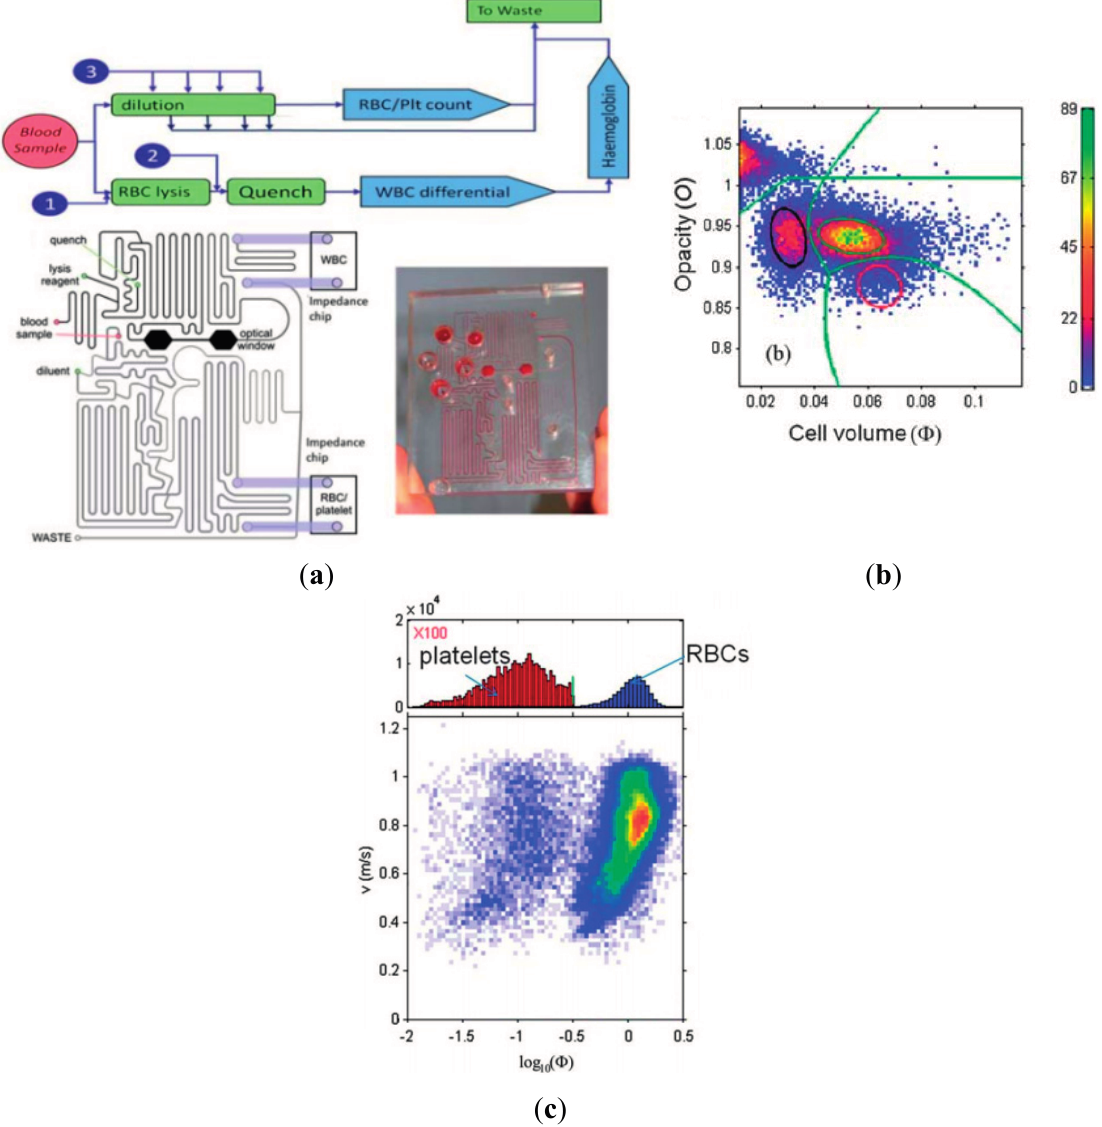
Figure 8. ( a ) The integrated point of care system based on microfluidic impedance flow cytometry enabling whole blood cell counting. The integrated system consists of two parts, an impedance measuring chip and a microfluidic sample preparation block. The bottom arm performs analysis of white blood cells with erythrocytes lysed while the upper arm performs counting of red blood cells and platelets; ( b ) The impedance scatter plot of cell membrane opacity vs. the electrical cell volume for classification of three main subpopulations of white blood cells (lymphocytes, monocytes and neutrophils); ( c ) Counting of red blood cells and platelets was performed based on single-frequency impedance data, where the cells are easily differentiated by sizes